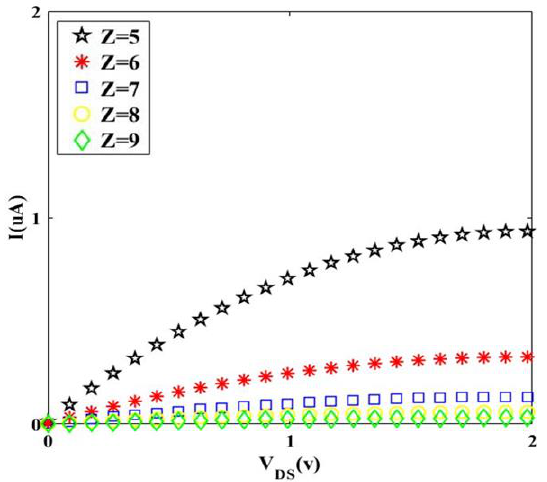
Figure 8. I-V characteristic for different values of Z at room temperature (S =